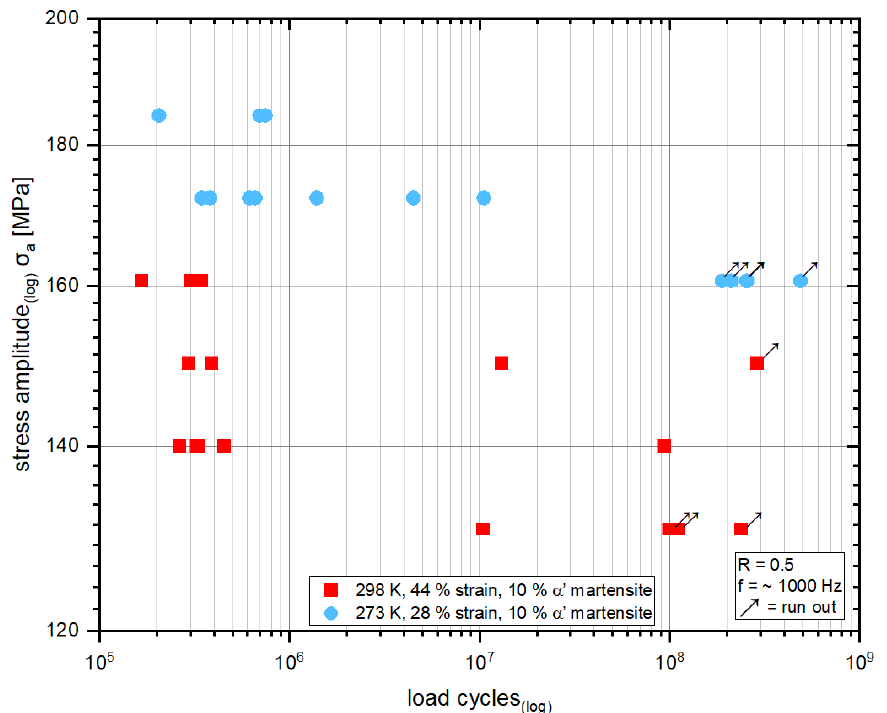
Figure 8. S-N diagram of fatigue tests on laser-cut AISI 304.